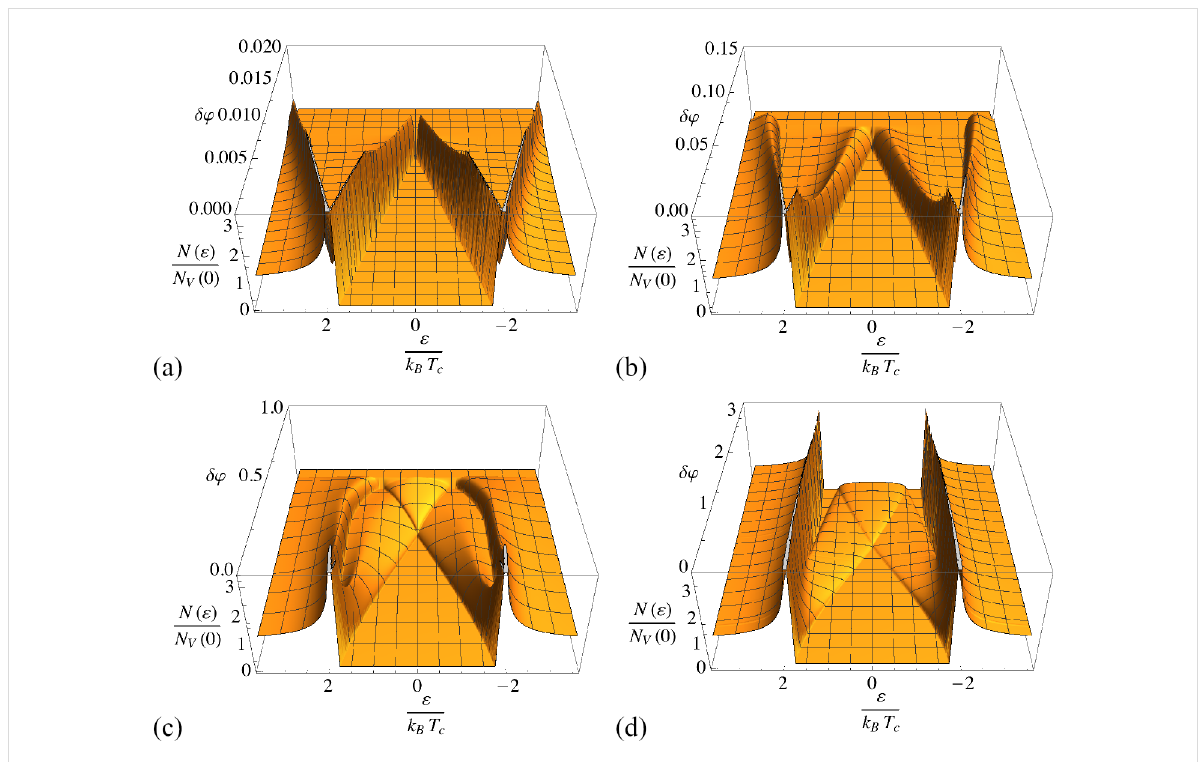
Figure 3: Density of states in a superconductor in proximity to a ferromagnetic insulator indicated by the spin mixing angle δφ , with (from (a) to (d)) ε ’ = 100,10,1,0.1, while the superconducting order parameter is evaluated self-consistently ( T ≪ T c ).